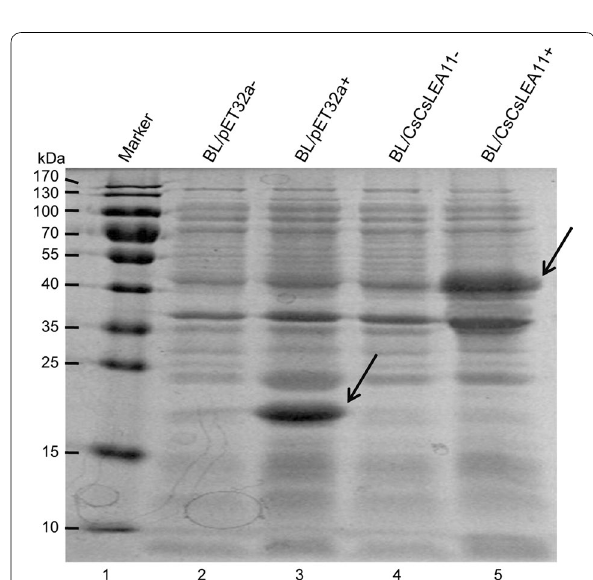
Fig. 5 SDS-PAGE analysis of TrxA-CsLEA11 fusion protein in E. coli cells before and after IPTG induction. Lane 1, marker; lane 2, BL/ pET32a without IPTG induction; lane 3, BL/pET32a after IPTG induc- tion; lane 4, BL/CsLEA11 without IPTG induction; lane 5, BL/CsLEA11 after IPTG induction. The arrows indicate the protein band corre- sponding to the